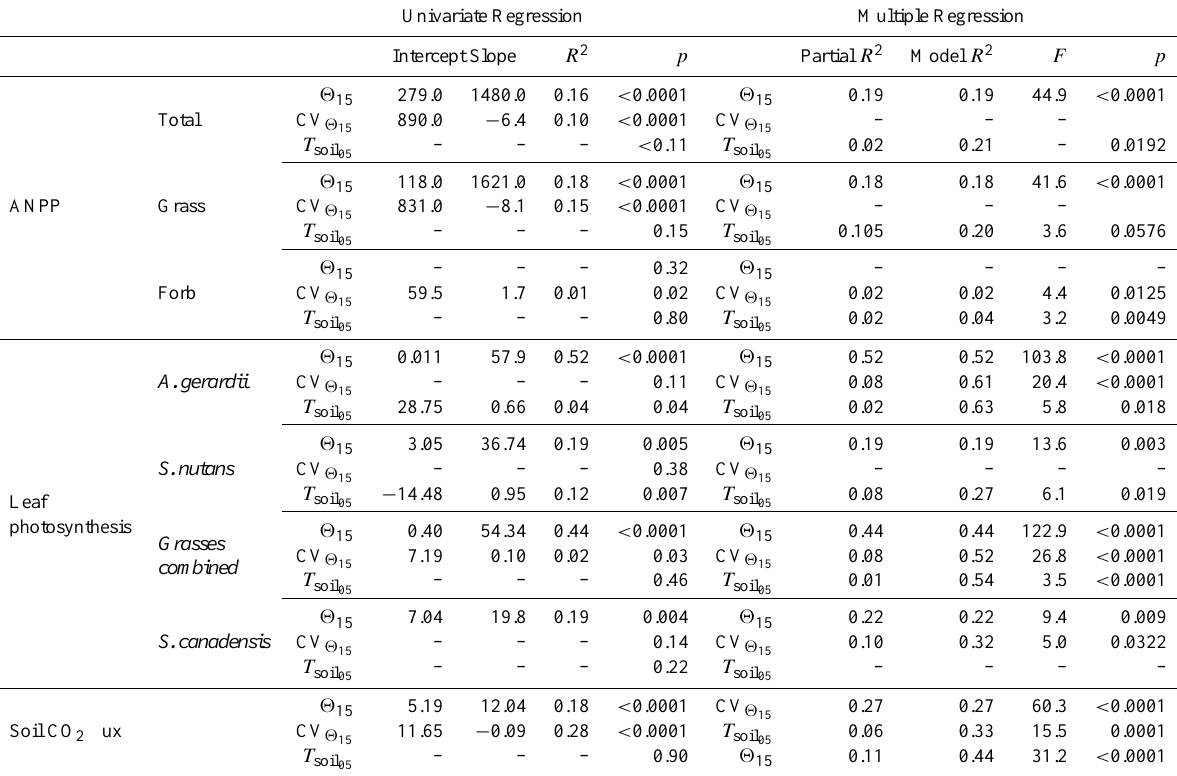
Table 1. Regression parameters and statistics for mean soil moisture at 15cm depth ( 2 15 ), intra-annual season soil moisture variability ), and soil temperature at 5cm depth ( T soil at 15cm depth (CV 2 ) from univariate and multivariate regression models for ANPP, leaf 15 05 photosynthesis, and soil CO 2